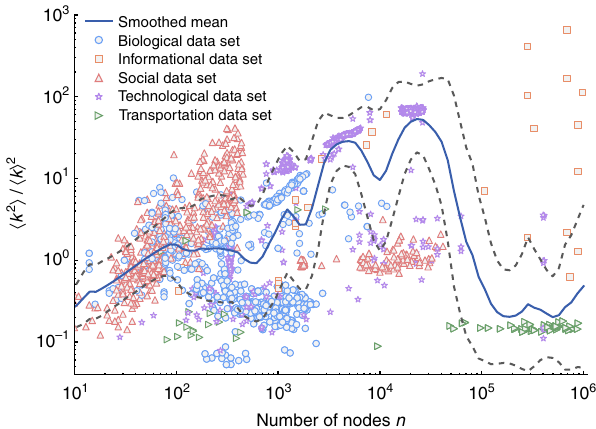
Fig. 7 Moment ratio scaling. For 3662 degree sequences, the empirical ratio of the second to fi rst moments h k 2 i = h k i 2 as a function of network size n , showing substantial variation across networks and domains, little evidence of the divergence pattern expected for scale-free distributions, and perhaps a roughly sublinear scaling relationship (smoothed mean via exponential kernel, with smoothed standard deviations)